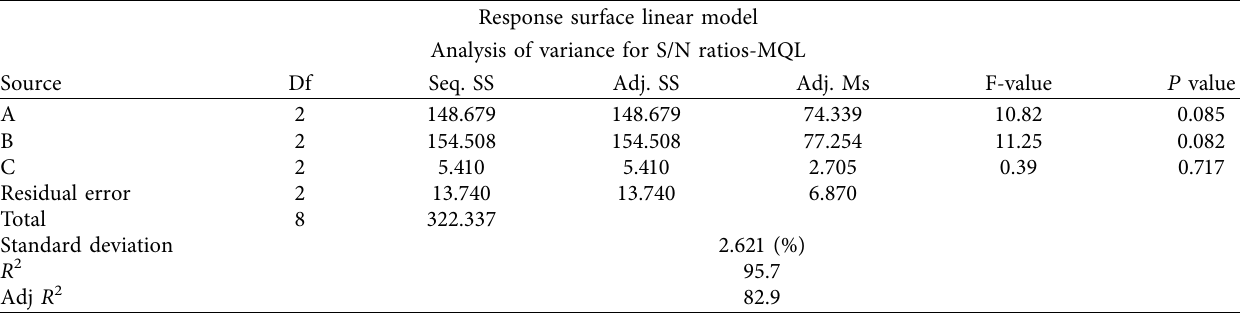
Table 8: ANOVA for S/N ratios (R